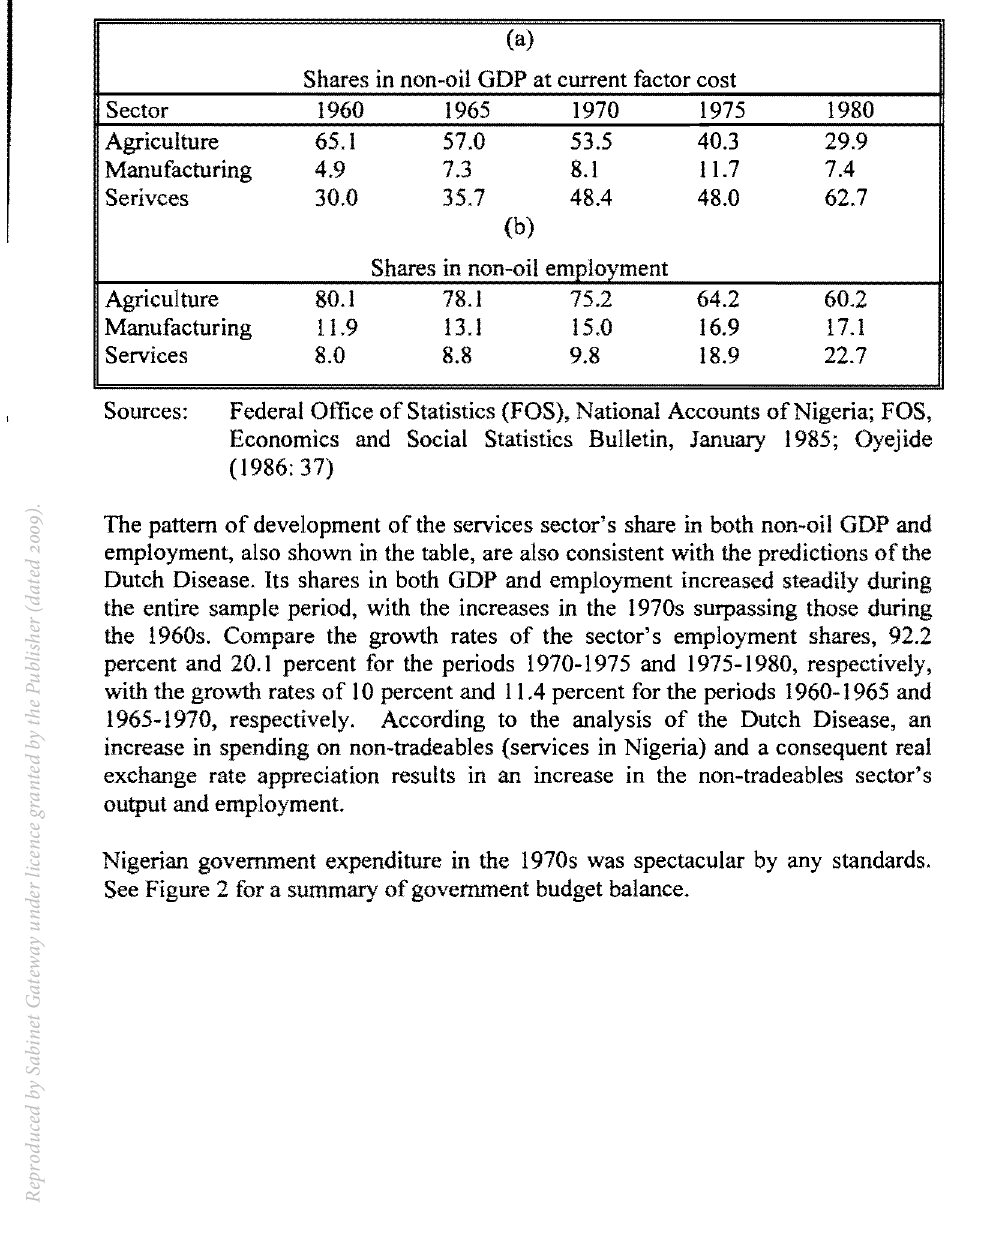
Table 1: Changes in Sectorial Contribution to Non-Oil GDP and employment, 1960-1980 (per cent) (a) Shares in non-oil GDP at current factor cost